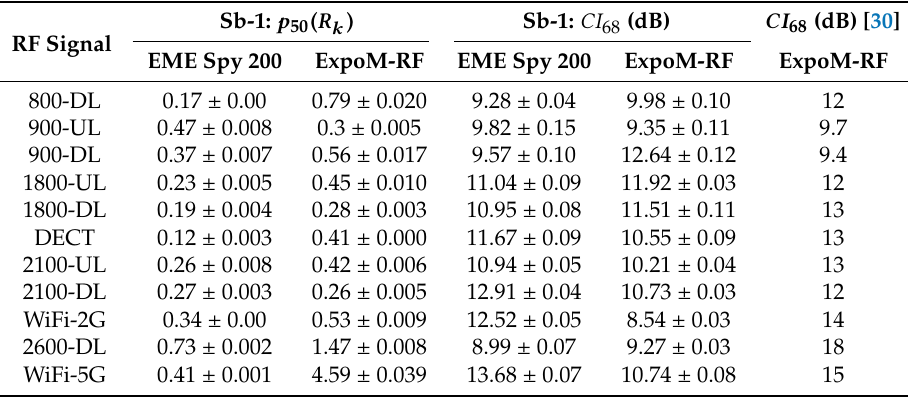
Table 3. The median and CI 68 of PEMs’ responses on hips of